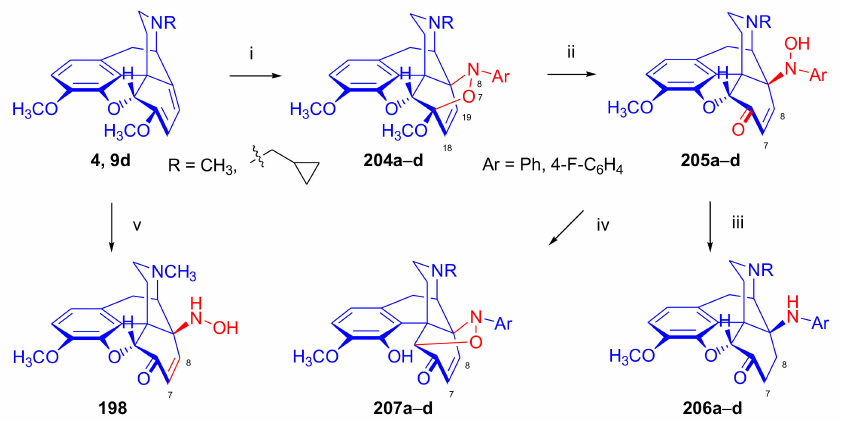
Figure 55. Synthesis of 14-(arylhydroxyamino)codeinone derivatives. Reagents and conditions : (i): nitrosobenzene or 4-fluoronitrosobenzene, CH 2 Cl 2 , room temperature, 5 min, 57–91%; (ii): 1M HCl, room temperature, 3 h, 55–91%; (iii): H 2 , Pd-C, MeOH, 3.8 bar, 2.5 h, 22–57%; (iv): NaOMe, MeOH, ∆